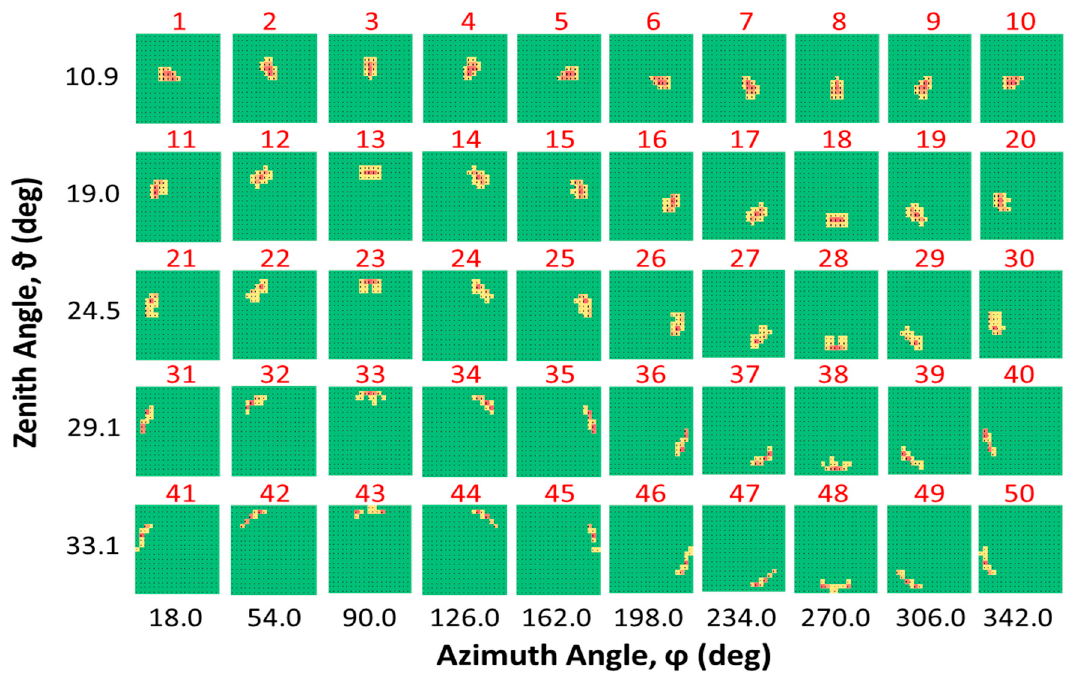
Figure 7. Distributions on the readout plane of rays incident to the instrument aperture from 50 directions.